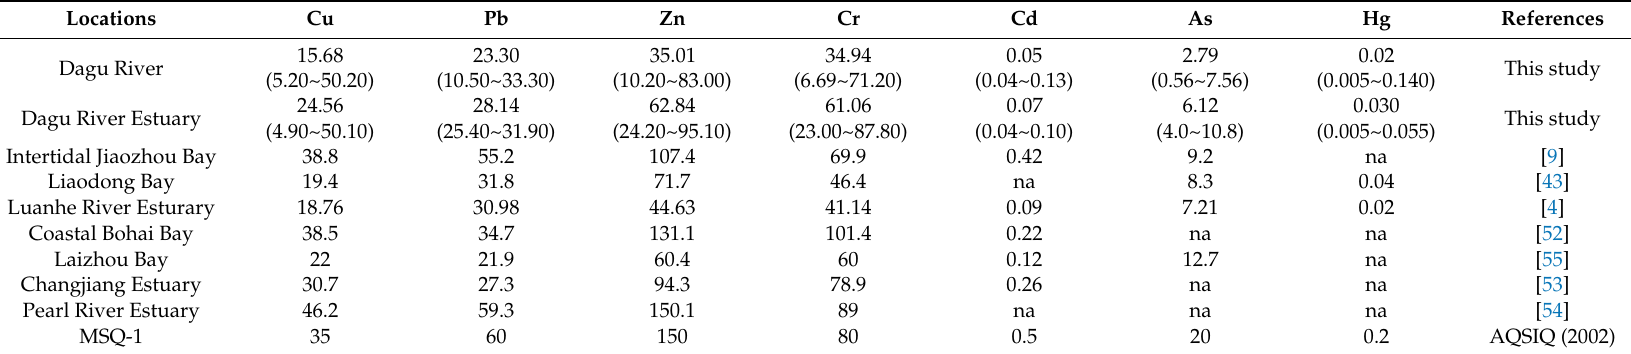
Table 1. Comparison of heavy metals and metalloids concentrations in the surface sediments of the Dagu River Estuary and other representative areas (unit: mg) kg − 1 ).